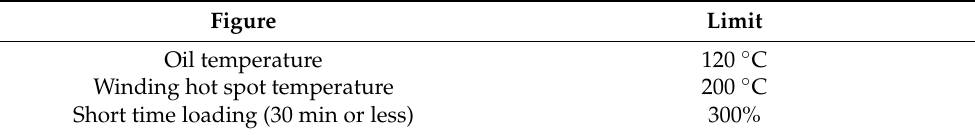
Table 8. Recommended limits of temperature and loading for a distribution transformer. Figure Limit Oil temperature 120 ◦ C Winding hot spot temperature 200 ◦ C Short time loading (30 min or less)